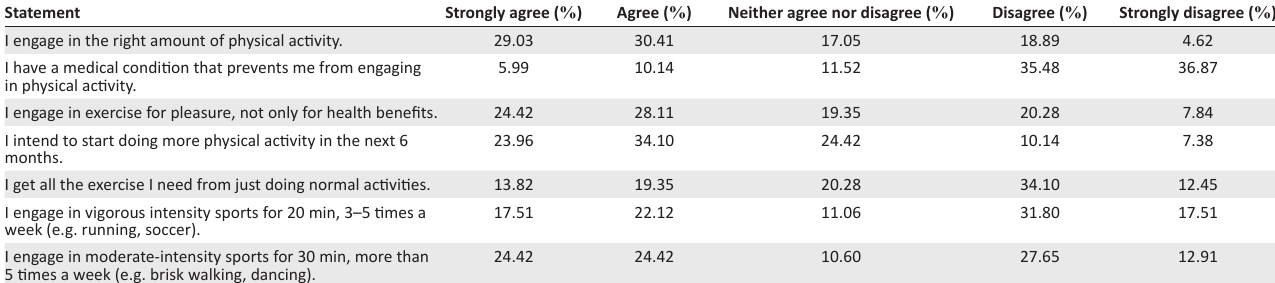
TABLE 5: Participants’ physical activity practices.